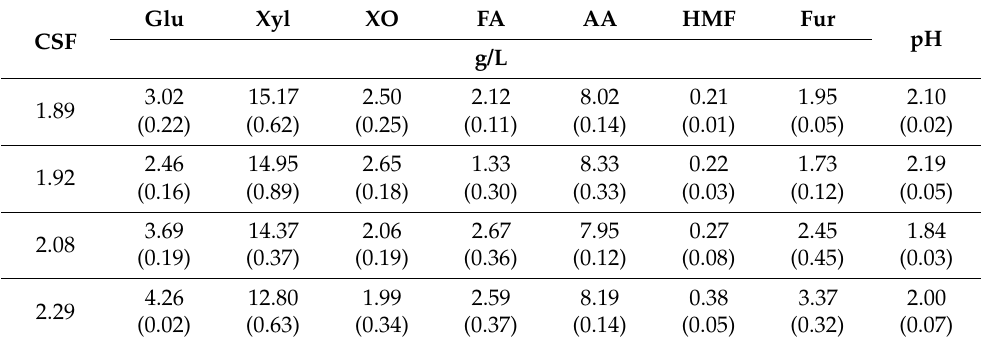
Table 2. Sugars, xylo-oligomer, and inhibitors in first hydrolysate, depending on oxalic acid pretreatment conditions [20].